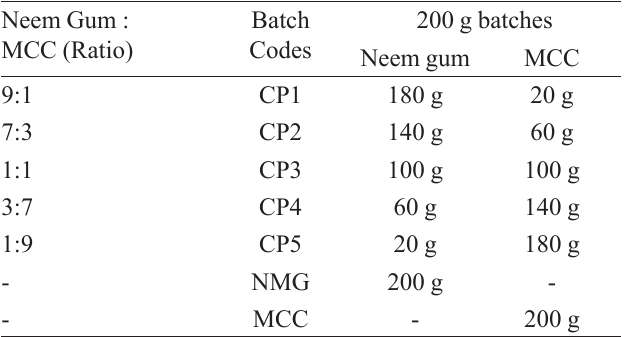
TABLE I - Formulae and codes of coprocessed excipients Neem Gum